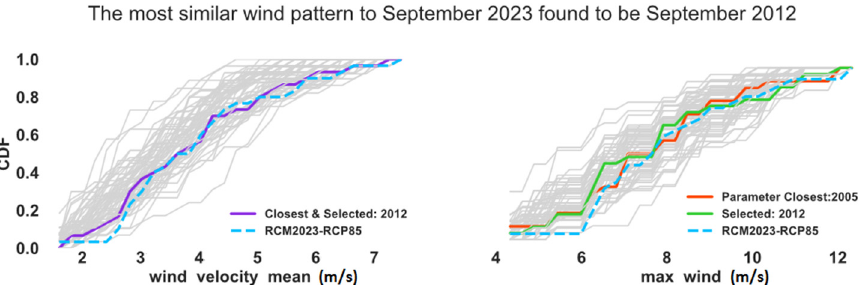
Figure 2. Downscaling a future month wind data using KNN.